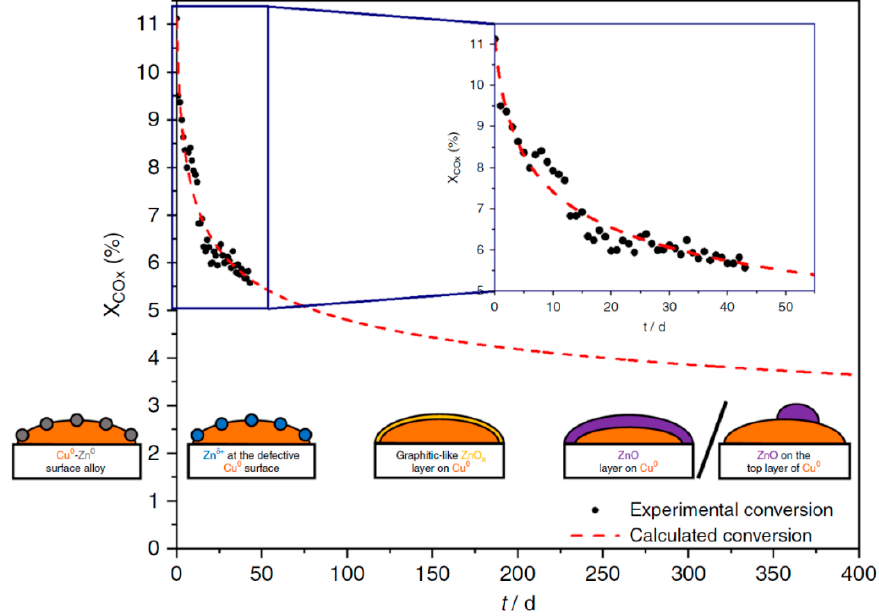
Figure 9. Long-term methanol synthesis over the industrial Cu/ZnO/Al 2 O 3 catalyst at 210 °C and 60 bar. Recorded degrees of conversion (black points) under differential controlled conditions. The dashed red curve describes the intra and extrapolation of the experimental data, which were calcu- lated with the MATLAB ® software according to the studies of Fichtl et al. [230]. Illustrations from left to right: Cu 0 –Zn 0 surface alloy according to Nakamura et al. [231]. Zn δ + species at the defective Cu 0 surface according to Behrens et al. [98], graphitic-like ZnO x layer on Cu 0 according to Lunkenbein et al. [126]. ZnO layer on Cu 0 according to Lunkenbein et al. [229] as well as Fichtl et al. [230] and ZnO on the top layer of Cu 0 according to Kattel et al. [103]. Reprinted with permission from ref. [125]. Copyright 2020 Springer.